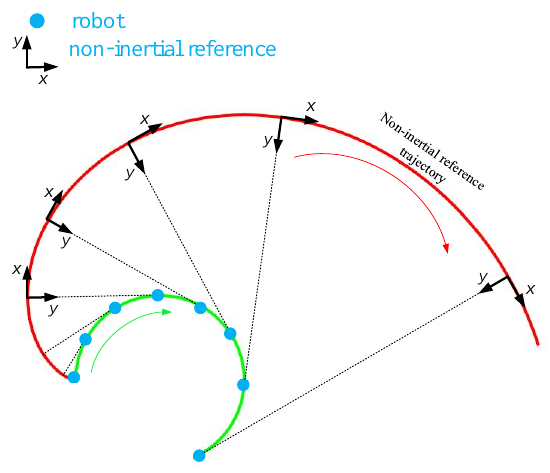
Figure 1. Non-inertial Reference in turning walking.